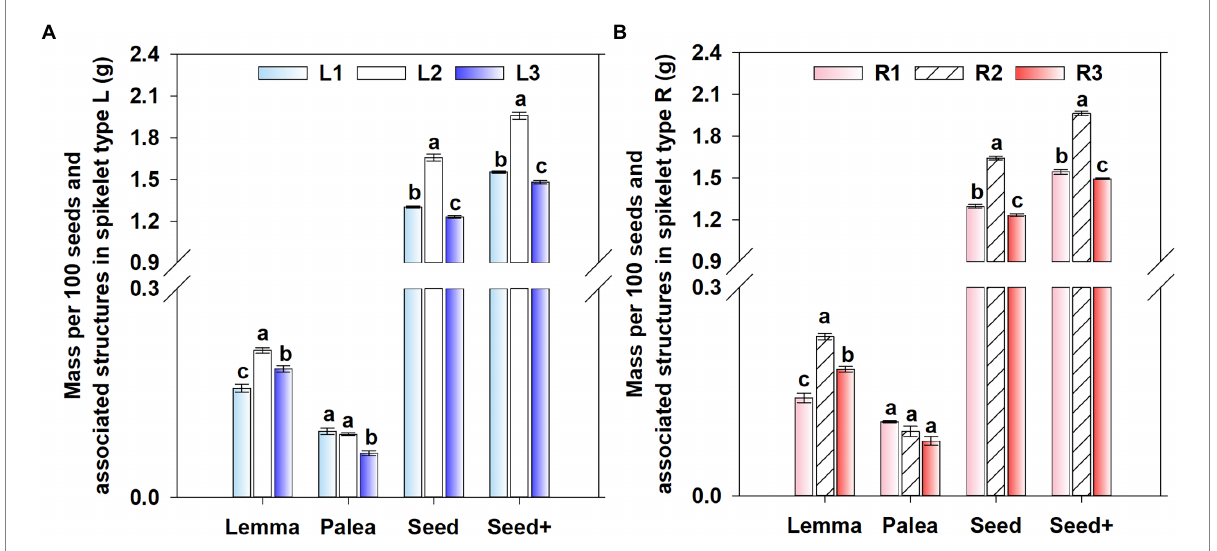
FIGURE 3 Mass per 100 seeds and associated structures in the spikelet type L (A) and R (B) of Aegilops tauschii . L, spikelet type Left; R, spikelet type Right; Seed, seed without lemma and Palea; Seed+, seed with lemma and palea; numbers 1, 2 and 3 following abbreviations indicate different seed groups. Different lowercase letters between seed groups for each dimension and each type of spikelet indicate significant differences (Tukey’s HSD, p =